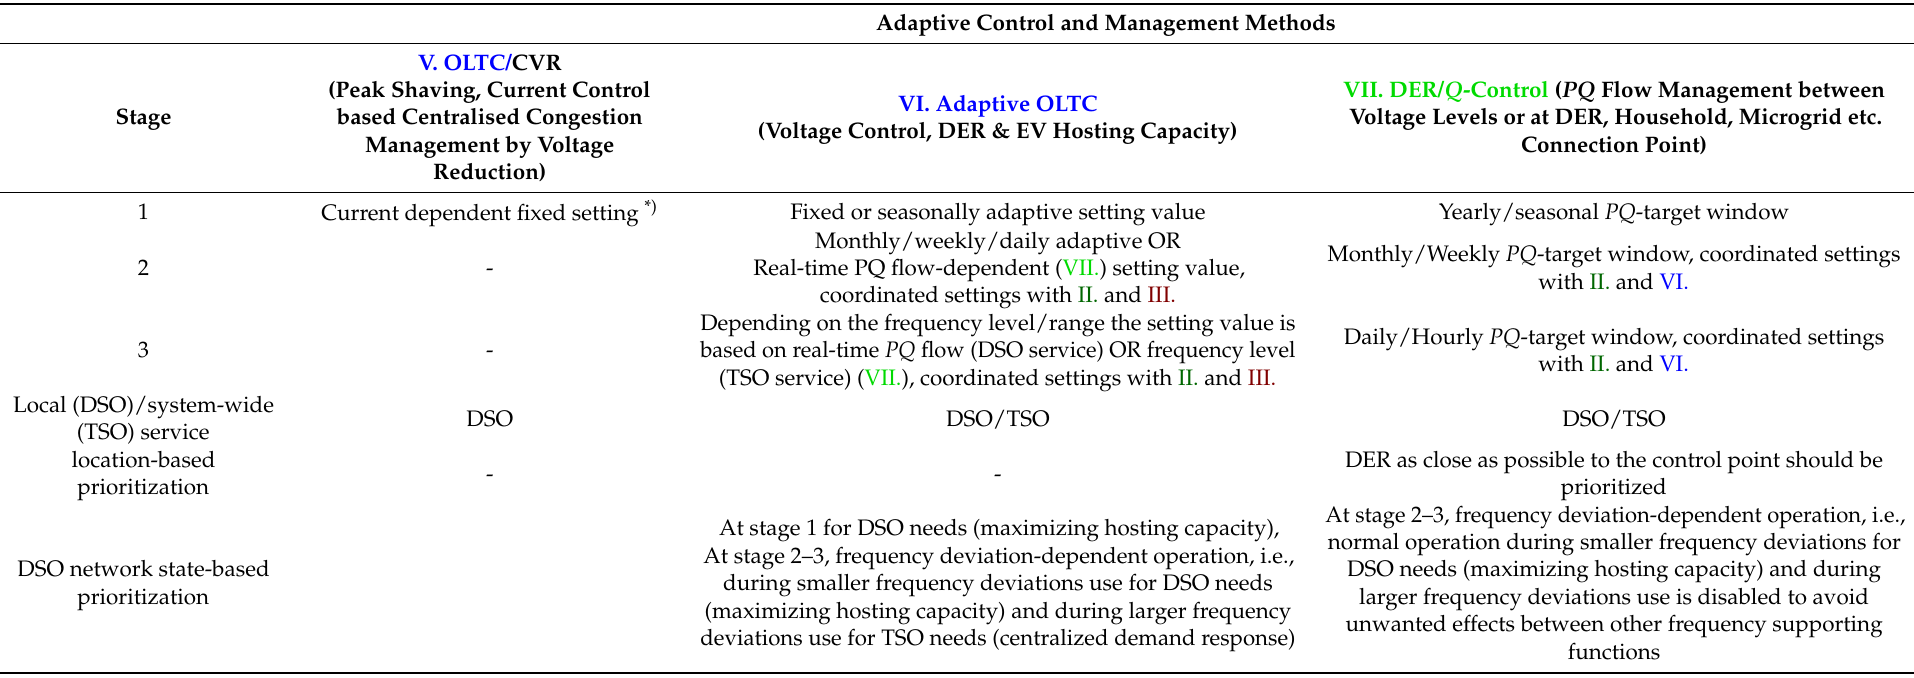
Table 5. Adaptive control and management methods V.–VII. evolution during different stages 1–3 and related issues. (see Figure 3, Tables 3 and